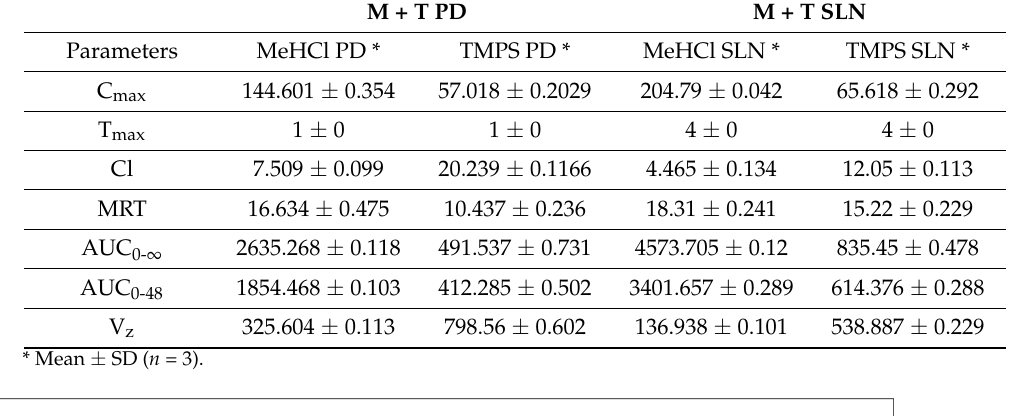
Table 3. Pharmacokinetic parameters of MeHCl + TMPS PD & MeHCl + TMPS SLN were adminis- tered intraperitoneally at 30 mg/kg (1:3 molar ratio).